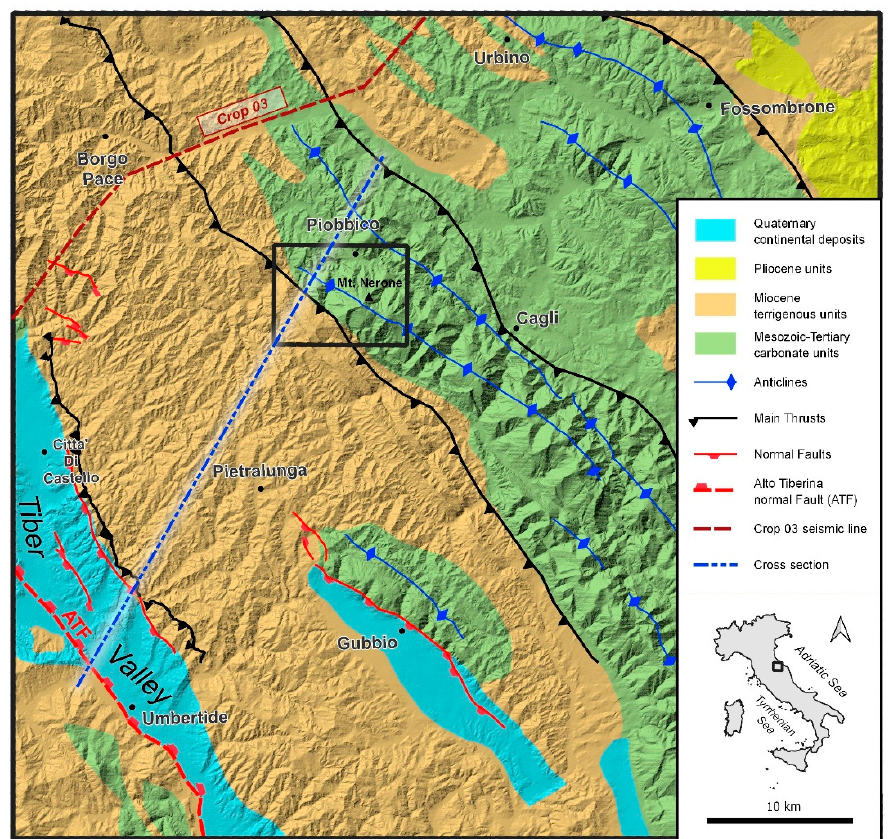
Figure 1. Schematic tectonic map of the northern sector of the Umbria–Marche Apennines (northern Apennines), showing the study area by the black rectangle (Figure 2) and the trace of the cross-section